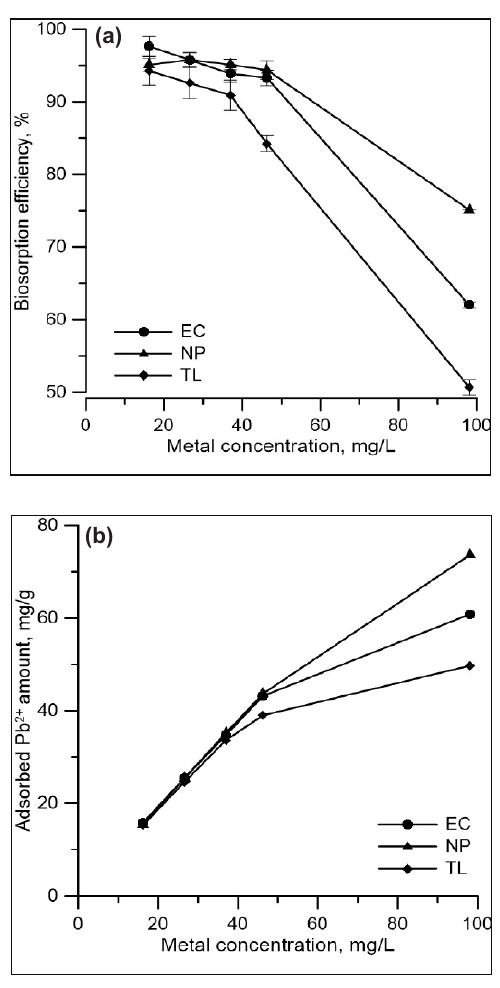
Fig. 4. Influence of metal ion concentration on biosorption efficiency (a) and on adsorbed lead amount